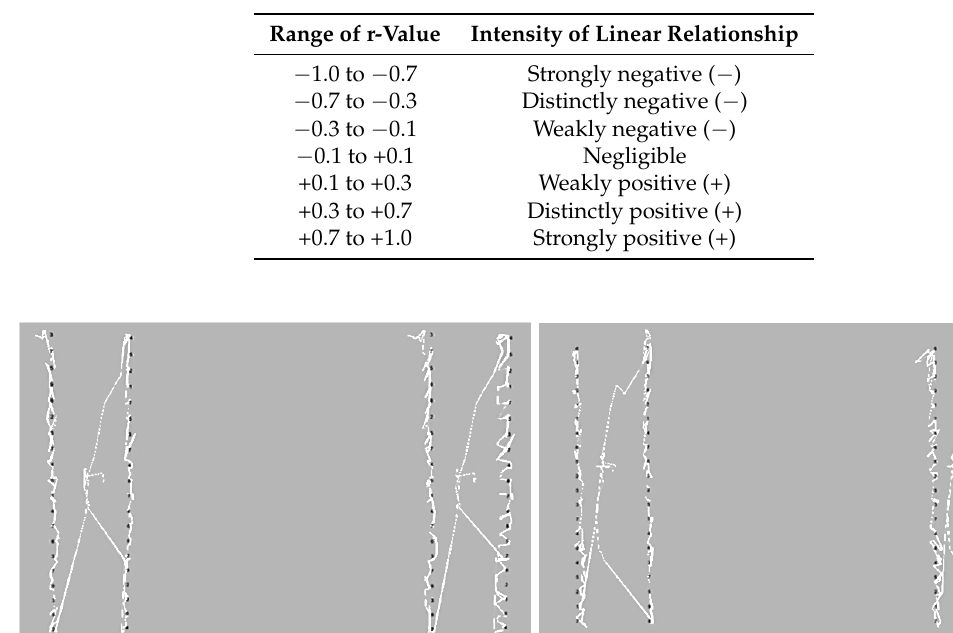
Table 1. The intensity of correlation by the range of the r-value.